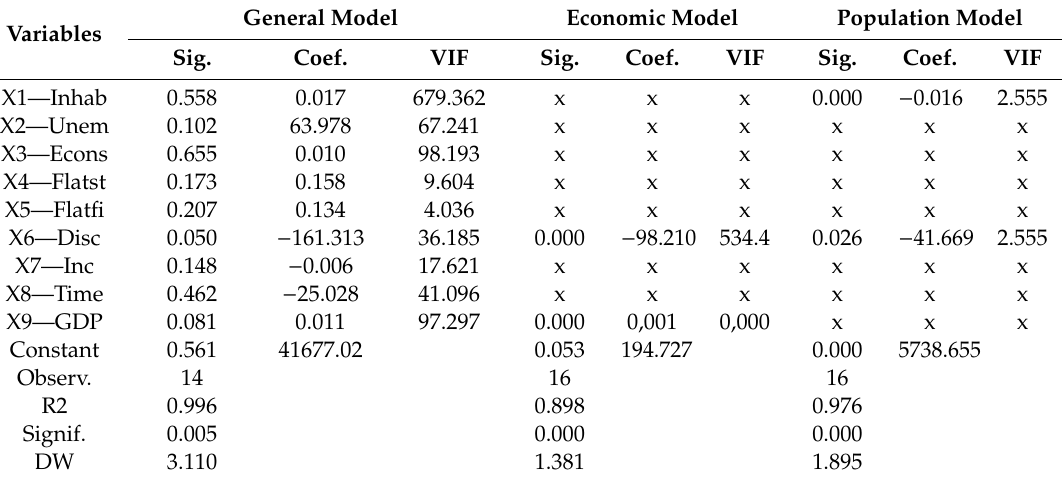
Table 4. Regression analysis for